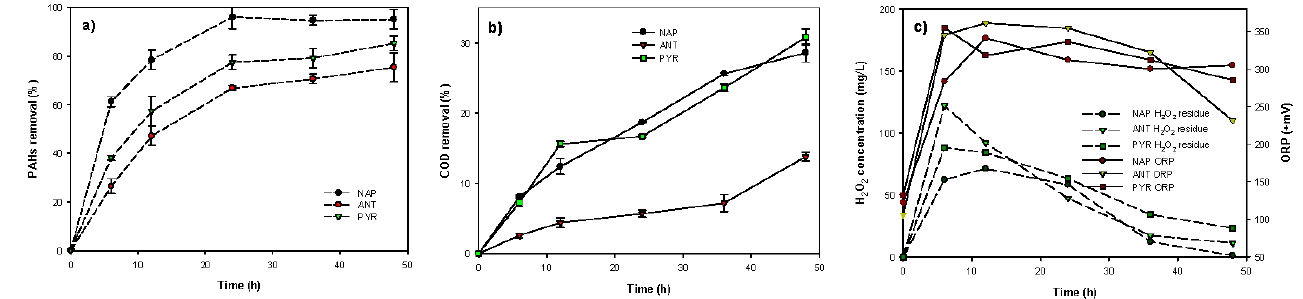
Figure 2. Bio-Fenton reaction for the three antibiotic degradations: ( a ) PAH removal; ( b ) COD removal; ( c ) H 2 O 2 residue and ORP conditions during Bio-Fenton.